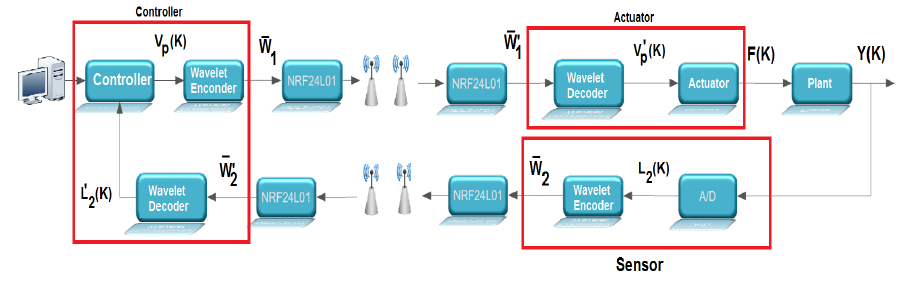
Figure 5. Detailed view of the structure of the control loop developed to perform the experimental tests.